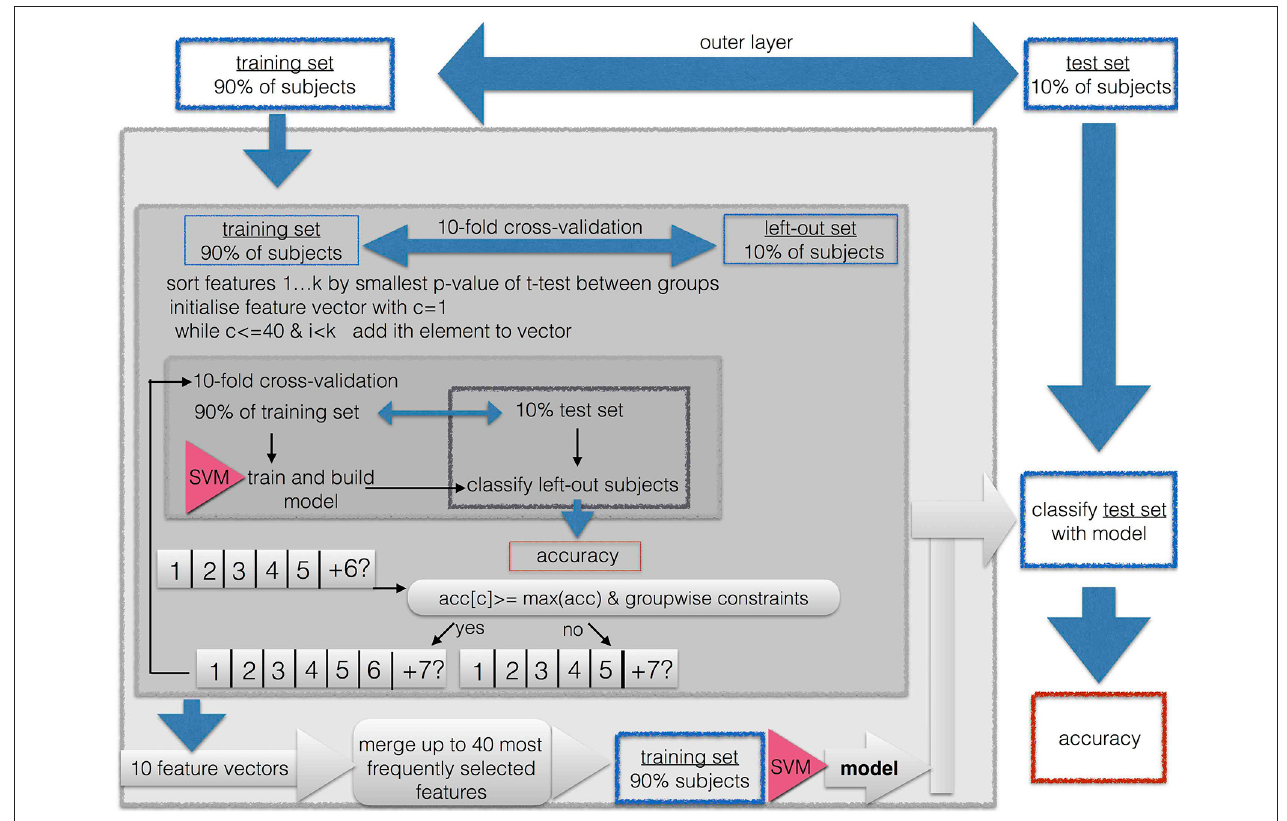
FIGURE 1 | Procedure of cross-validation, classification, and feature subset selection.